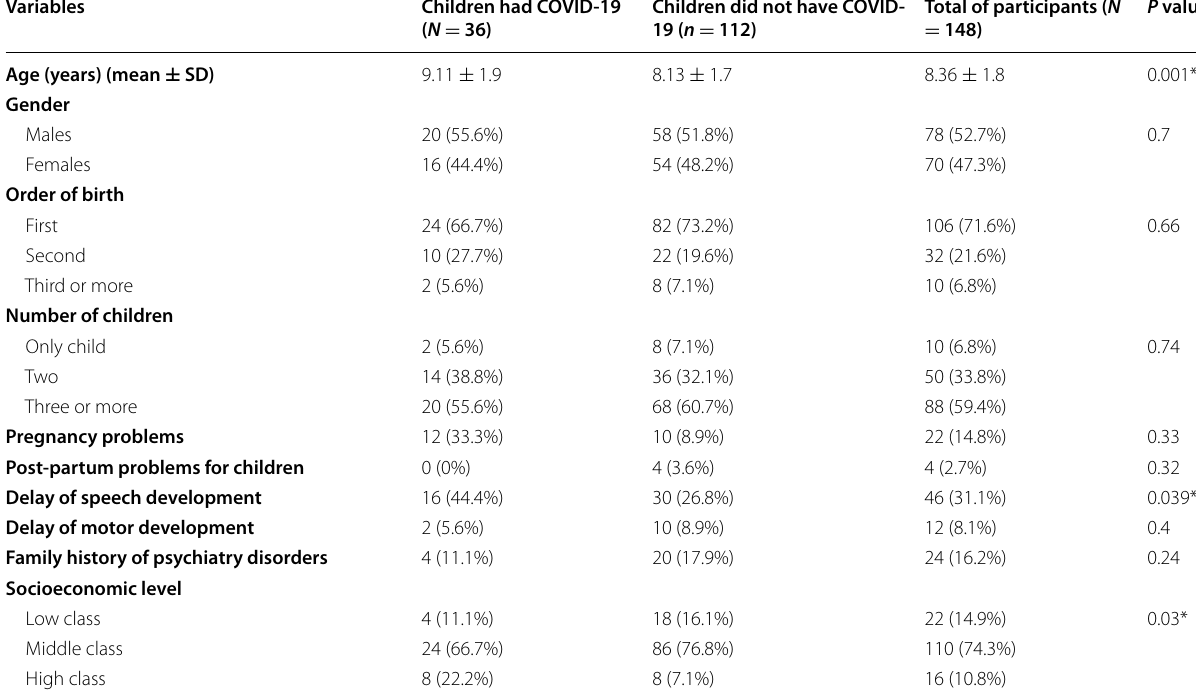
Table 1 Sociodemographic data of studied